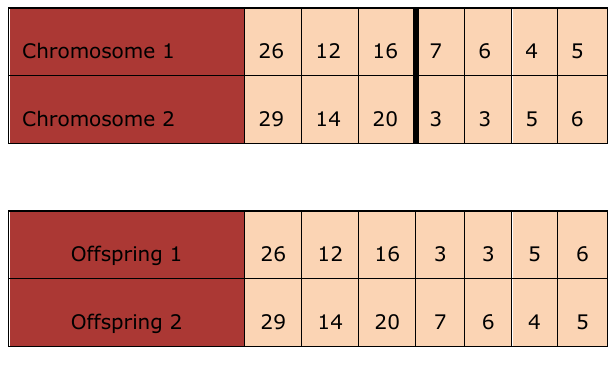
Figure 4. Single point crossover